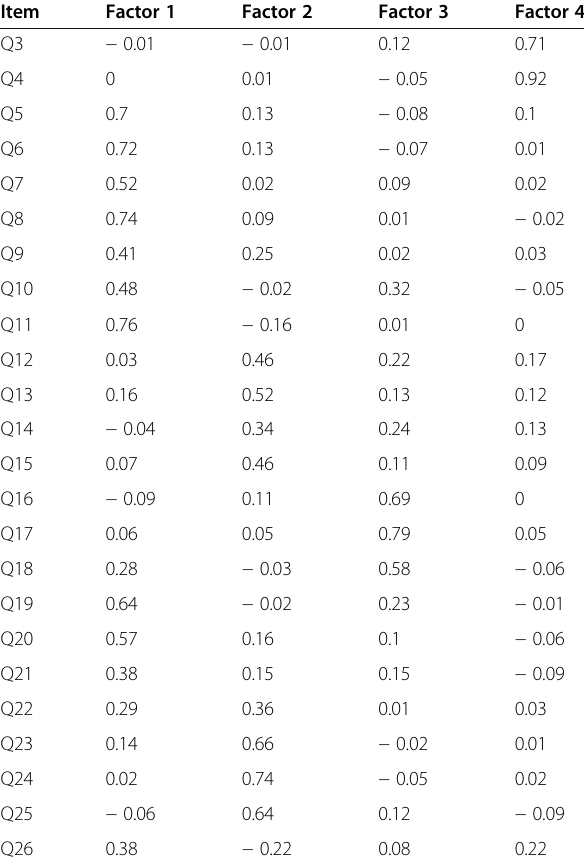
Table 3 Factor loadings for the four-factor solution obtained with